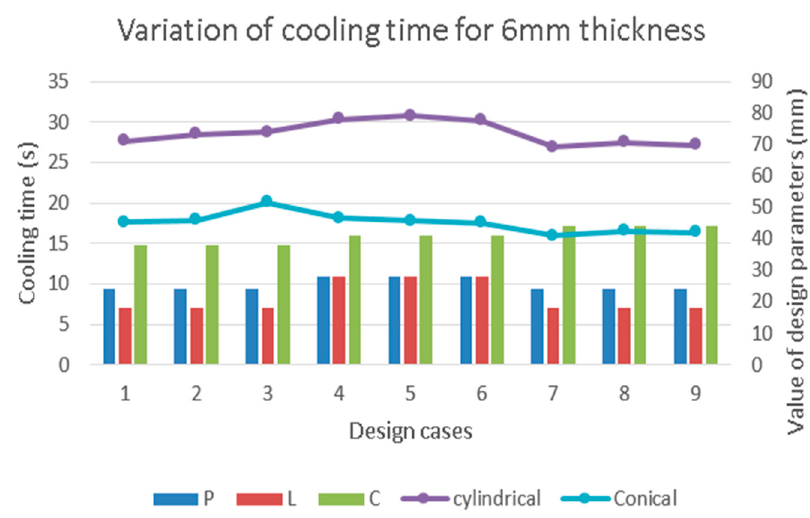
Figure 9. Cooling time variation for six-mm thick plastic parts (both cylindrical and conical).